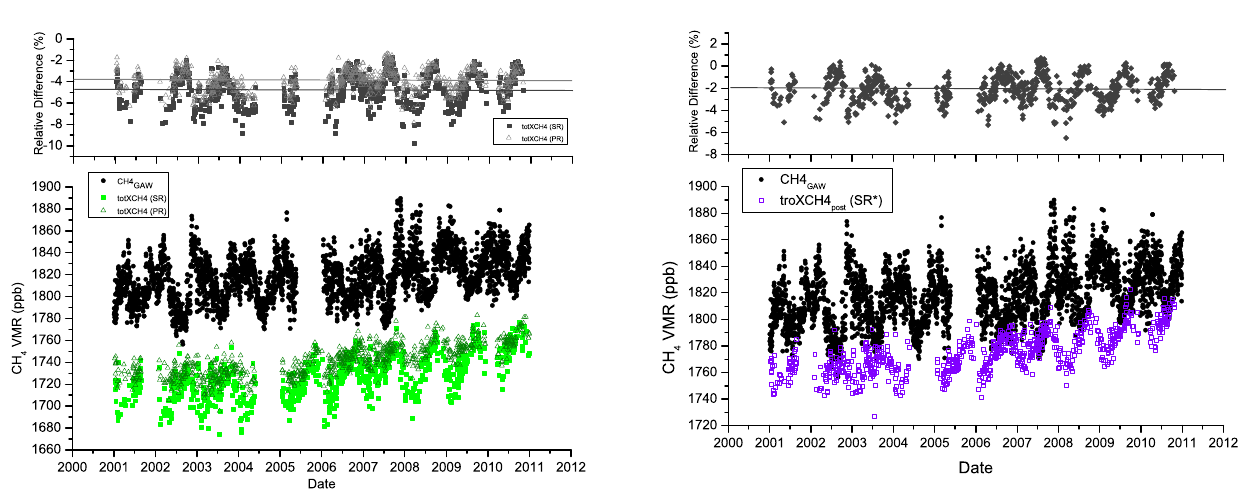
Fig. 6. Same as Fig. 5, but for the a posteriori-corrected tropospheric XCH 4 calculated from the total CH 4 column obtained from the scal- ing retrieval and applying the HF correction (troXCH 4 , violet post empty squares). Table 6. Statistics of the daily mean comparisons between the FTIR ) and the GAW products (totXCH 4 , troXCH 4 , and troXCH 4 post retr data for the period